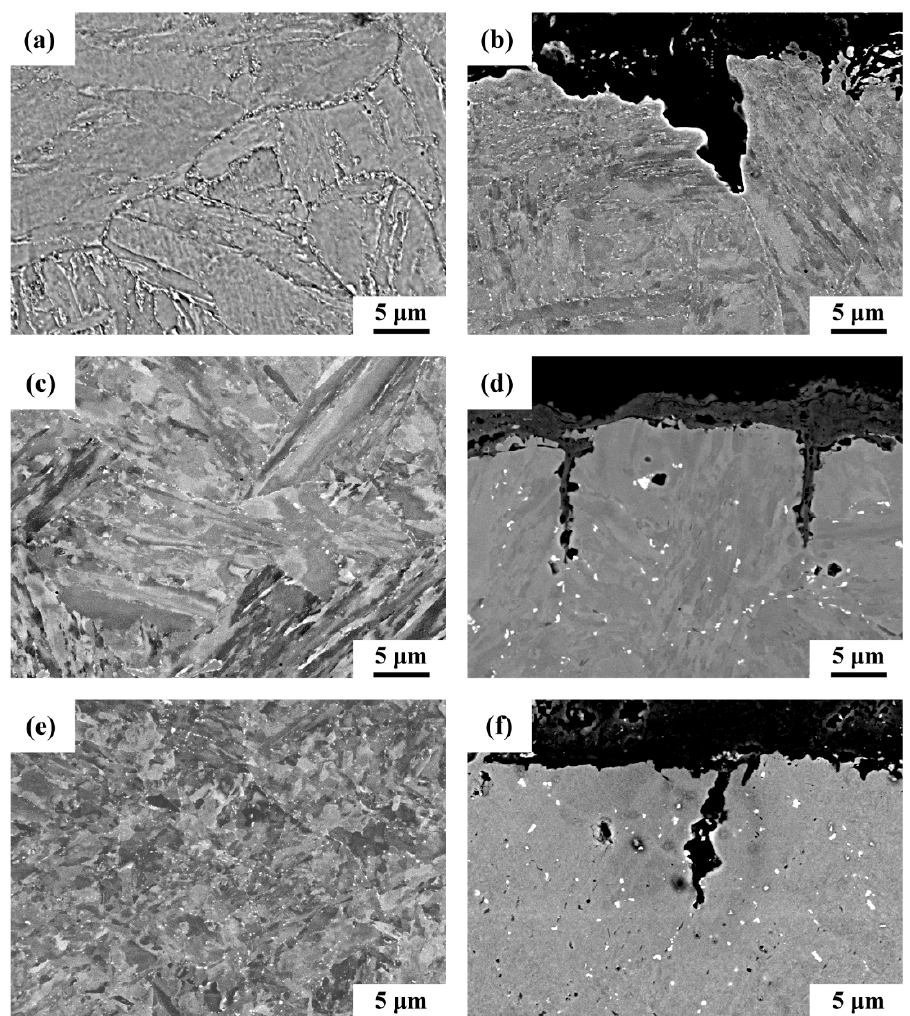
Figure 9. Changes in the microstructures of the samples before and after the creep-straining at 660 ◦ C/80 MPa: ( a , b ) WT, ( c , d ) WT-820T, ( e , f ) WT-890T samples.